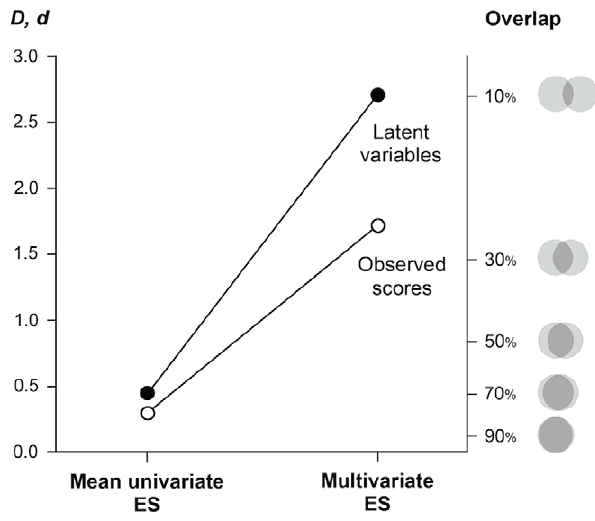
Figure 1. The magnitude of global sex differences in person- ality, estimated with different methods from the same dataset. The effect size (ES) increases dramatically as better methods are employed. The male-female overlap (right-hand axis) is calculated on the joint distribution assuming multivariate normality.